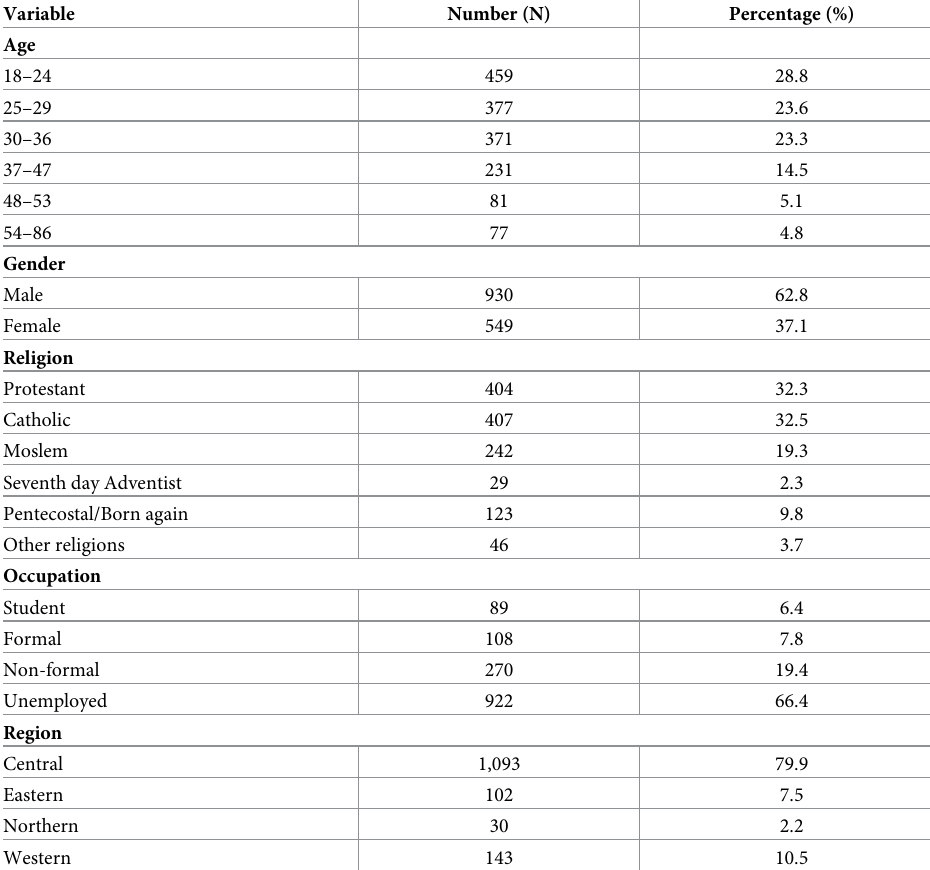
Table 1. Background characteristics of all patients who reported for the first time in